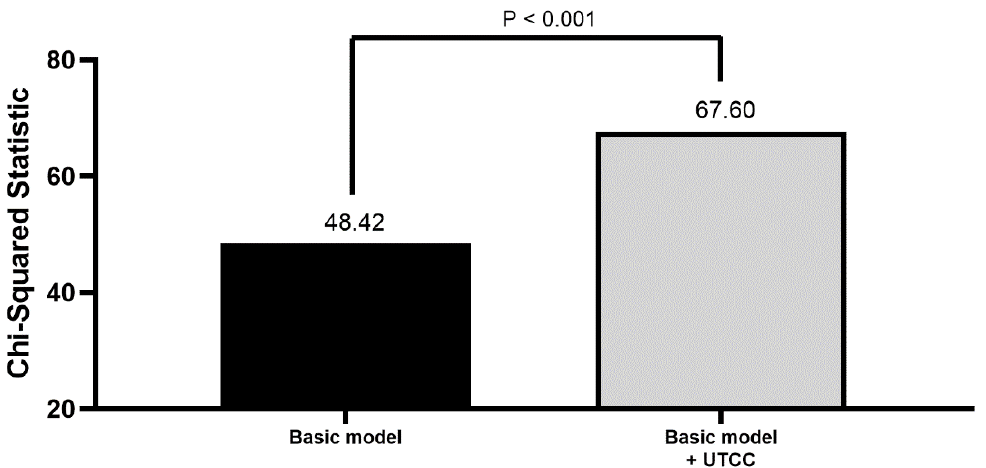
Figure 2. The additive e ff ect of UTCC on overall mortality prediction by calculating the improvement in global Chi-square value. Basic model included age, gender, hypertension, heart rate, body mass index, left ventricular ejection fraction, Charlson comorbidity index, and ankle-brachial index. Abbreviation: UTCC, upstroke time per cardiac cycle.